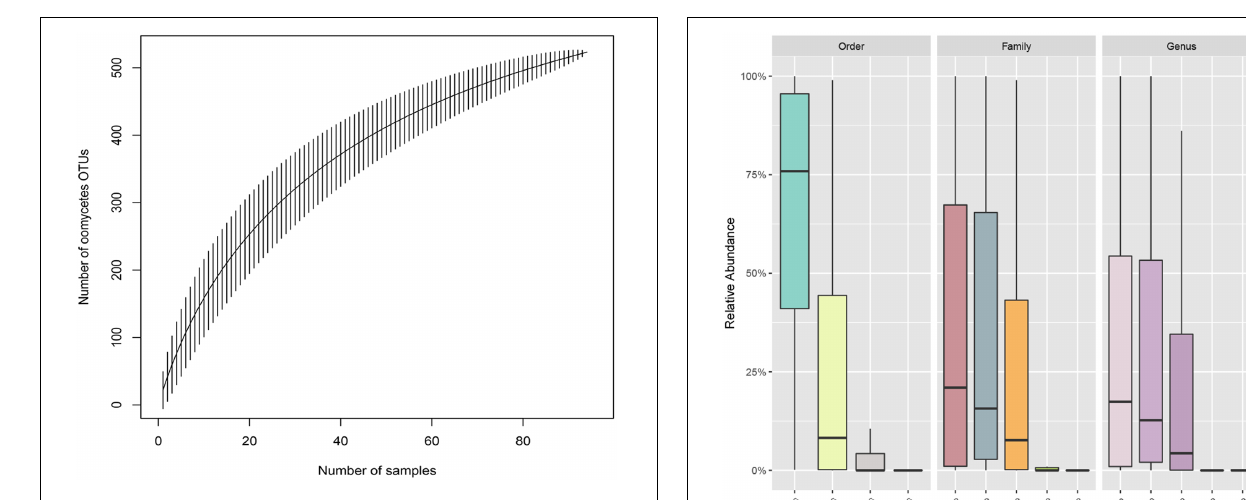
FIGURE 2 | Species accumulation curve for the 96 samples, obtained with the function specaccum of the ‘vegan’ R package; it shows the relationship between observed OTUs and number of samples.